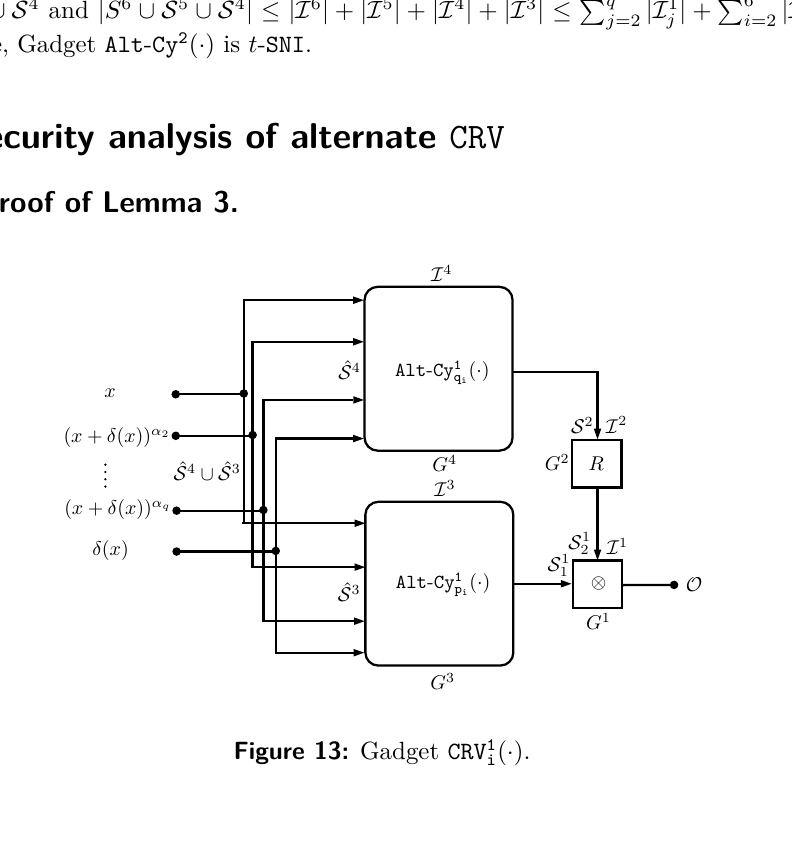
Figure 13: Gadget CRV 1